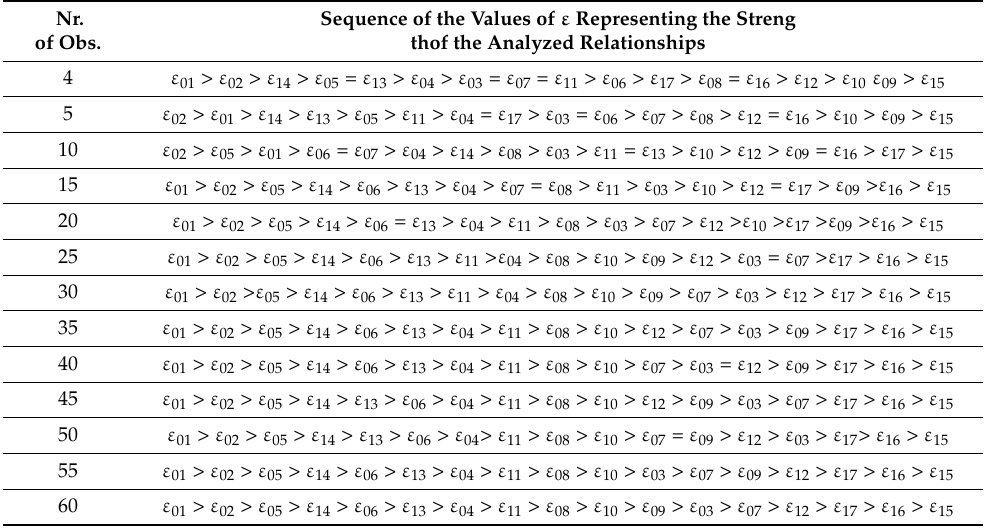
Table 3. The sequence of the calculated values of the similarity coefficient ε in terms of the number of observations included in the model. Nr. Sequence of the Values of ε Representing the Streng of Obs. thof the Analyzed